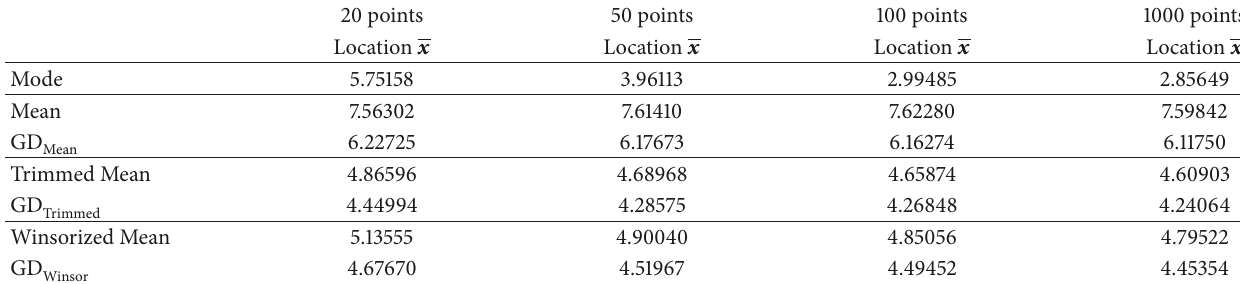
Table 50: Contaminated 𝜒 2 distributions with 50% noise level.